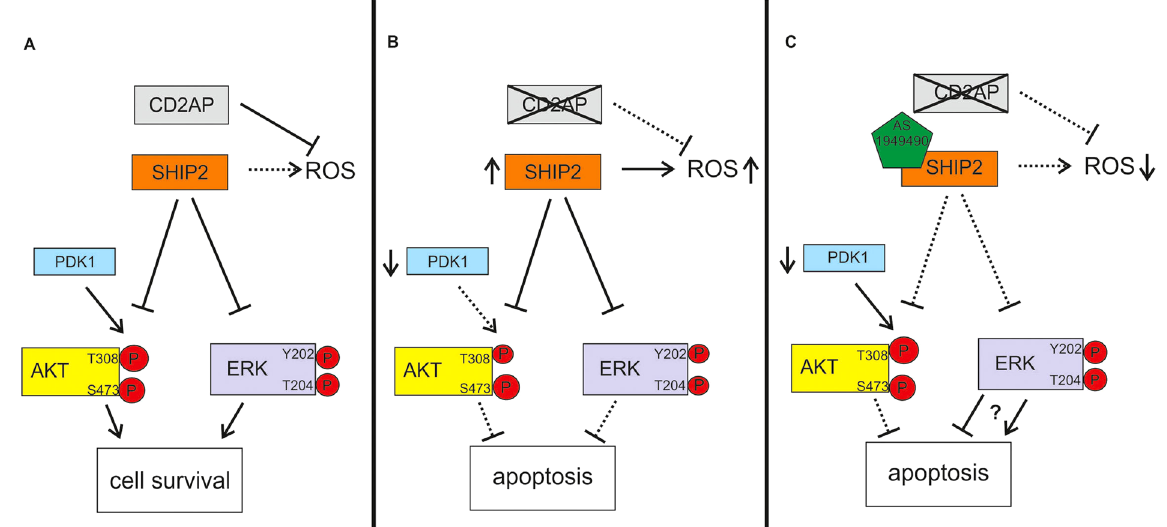
Figure 9. Schematic model illustrating the effect of SHIP2 inhibition in CD2AP-deficient podocytes. ( A ) Wild type podocytes in basal state. CD2AP associates with SHIP2. CD2AP inhibits the production of ROS, and SHIP2 negatively regulates the pathways leading to AKT and ERK phosphorylation. The balance between the prosurvival and proapoptotic signals is maintained. (B) CD2AP − / − podocytes in basal state. The expression and activity of SHIP2 and generation of ROS are increased in the absence of CD2AP. Increased SHIP2 activity leads to low phosphorylation level of AKT and ERK. The expression of PDK1 is downregulated contributing to degreased phosphorylation of T308 of AKT. Decrease in prosurvival signalling manifests as increased apoptosis of the cells. (C) Inhibition of SHIP2 activity with AS1949490 in CD2AP − / − podocytes. Inhibition of the activity of SHIP2 leads to reduced generation of ROS. AS1949490 attenuates the potential of SHIP2 to negatively regulate AKT and ERK activity, yet the phosphorylation of S473 of AKT does not increase. Despite of low expression level of PDK1, the phosphorylation of T308 of AKT increases. As phosphorylation of both sites of AKT is required for its full activity, remains the balance between prosurvival and proapoptotic signalling disrupted and podocytes undergo apoptosis. It is also possible that increased ERK activation may contribute to an increase in apoptosis (see Discussion for